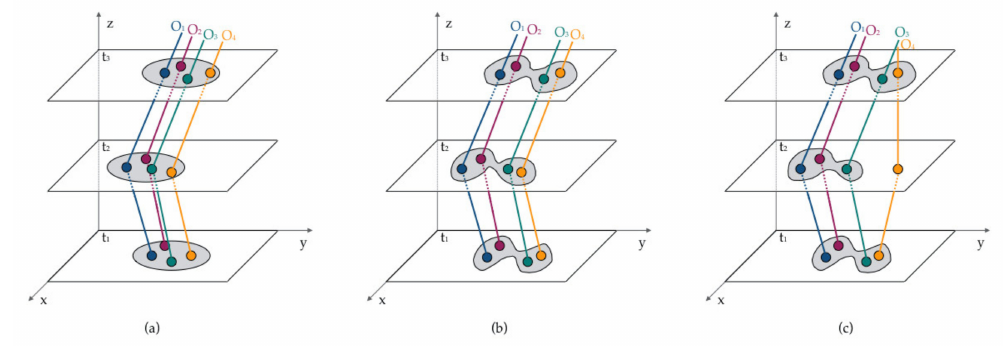
Figure 4. Collective pattern categories: ( a ) flock, ( b ) convoy, and ( c ) swarm [3]. Each image contains three timestamps (i.e., t 1 , t 2 , t 3 ) and four moving objects (i.e., O 1 , O 2 , O 3 , O 4